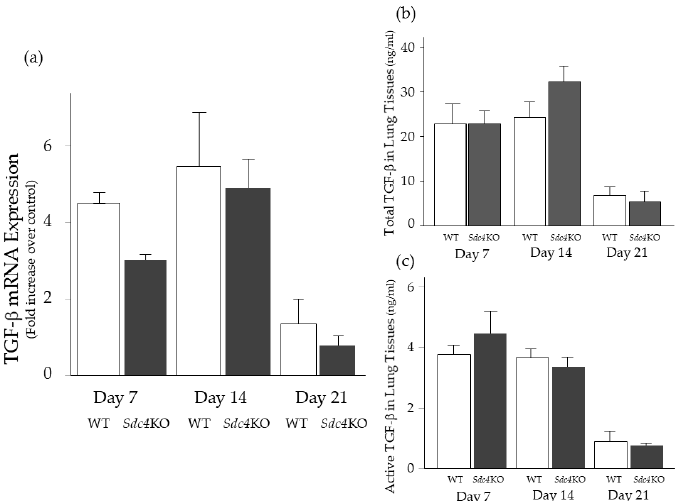
Figure 5. The expression of TGF- β in lung tissue after intratracheal bleomycin instillation. mRNA expression of TGF- β ( a ) and protein concentrations of total ( b ) and active ( c ) TGF- β in the lung tissue were not di ff erent between the wild-type (WT; n = 5–10) and syndecan-4-deficient ( Sdc4 KO; n = 6–11) mice at 7, 14 and 21 days after intratracheal bleomycin instillation. The di ff erence was compared using the Mann-Whitney U